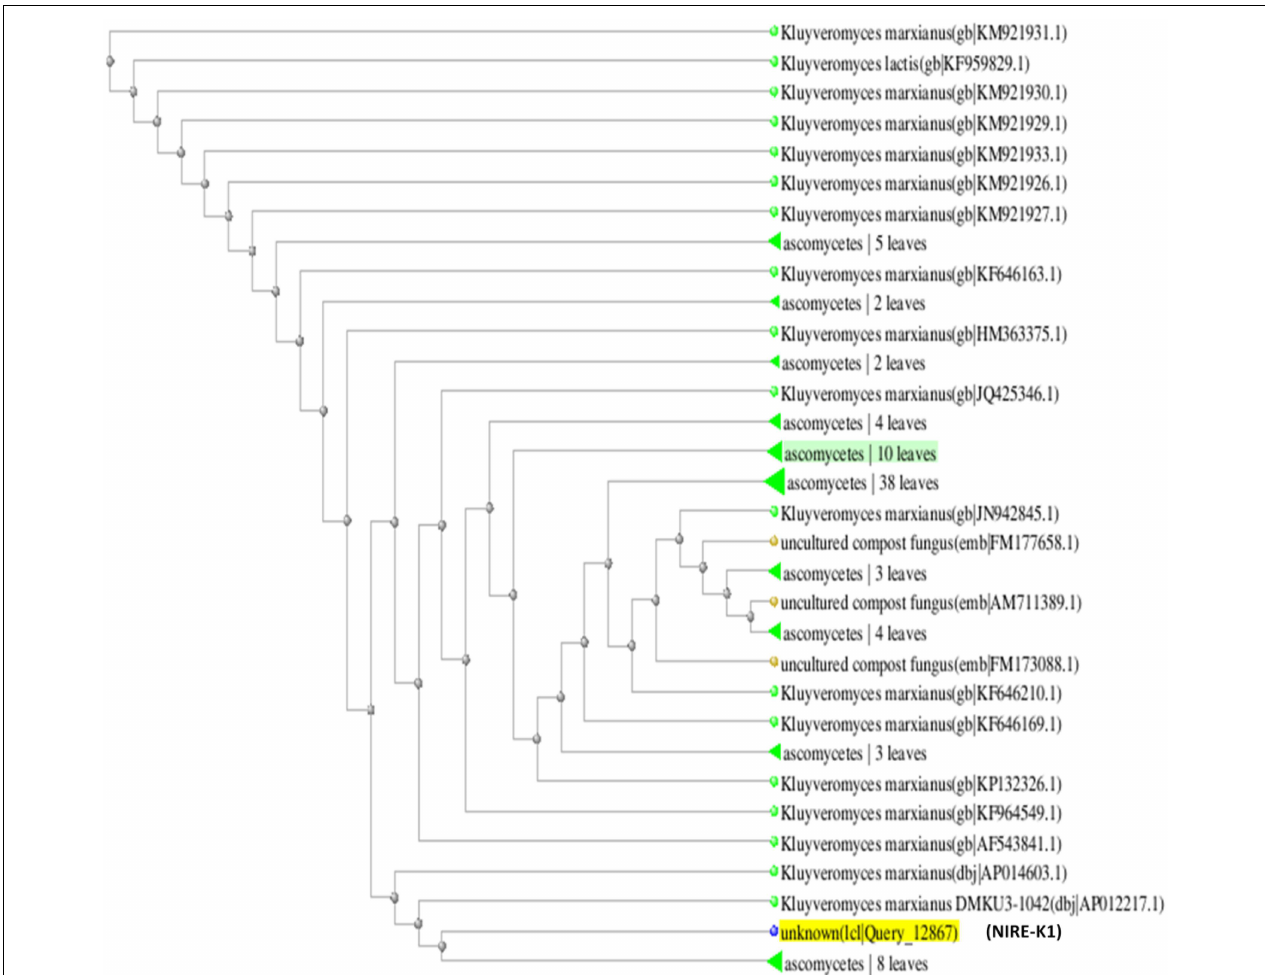
FIGURE 4 | Phylogenetic tree drawn through BLAST showing genetic relationship between K. marxianus NIRE-K1 and similar organisms.